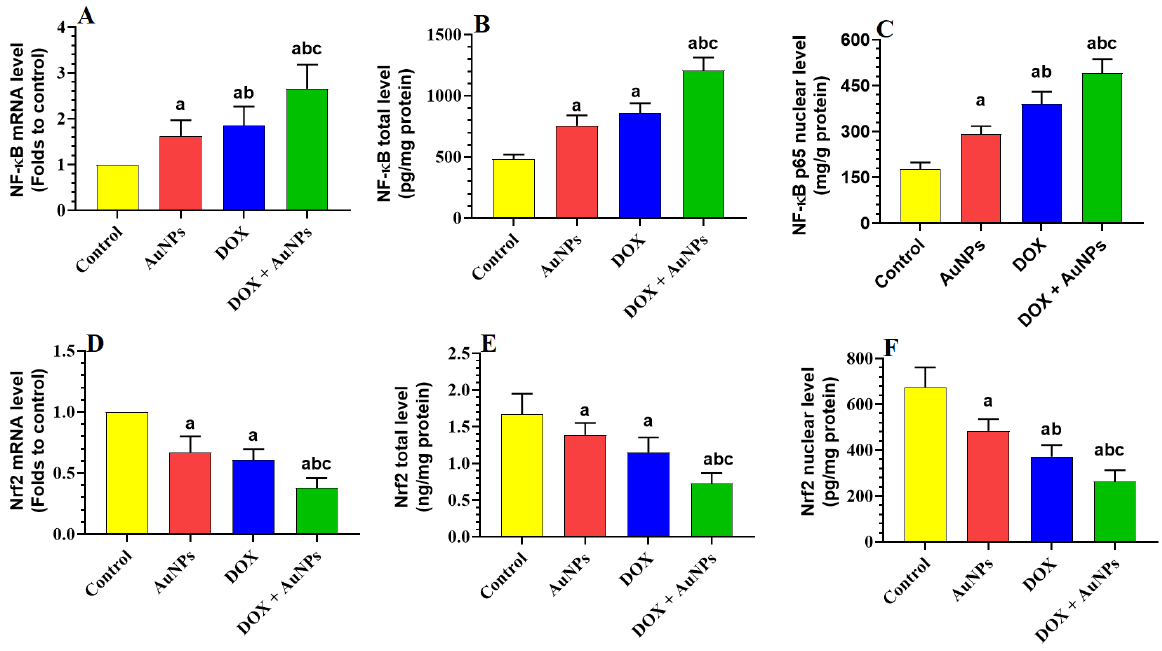
Figure 4. Effects of the individual or combined treatments with gold nanoparticles (AuNPs) and/or doxorubicin (DOX) on the transcription, total levels, and nuclear levels of NF-kB ( A – C ) and Nrf2 ( D – F ) in the liver of all experimental groups. Data were analyzed by 1-way ANOVA followed by Tukey’s test. Values are presented as means ± SD ( n = 8/group). Significance was considered at p < 0.5. a : vs. control rats; b : vs. AuNPs-treated rats; c : vs. DOX-treated rats.